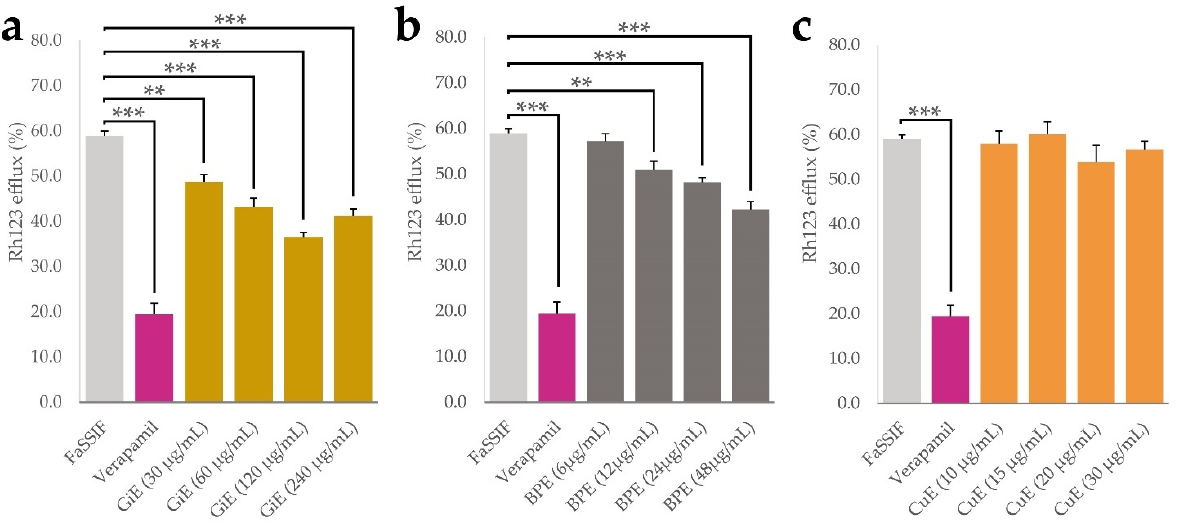
Figure 5. Results of the rhodamine 123 efflux assay, indicated as a percentage of the control without Rh123 efflux. After 30 min accumulation with Rh123 (10 μ M), GiE ( a ), BPE ( b ) and CuE ( c ) were applied in 4 different concentrations with the lowest one representing their respective concentrations in transport and uptake tests, while the concentration of verapamil was 50 μ M. FaSSIF medium was used as a negative control. After 1 h of incubation, intracellular Rh123 concentrations were determined. Error bars represent mean ± SEM ( n = 9–12). Statistically significant differences are denoted as ** ( p ≤ 0.01) and *** ( ≤ 0.001).